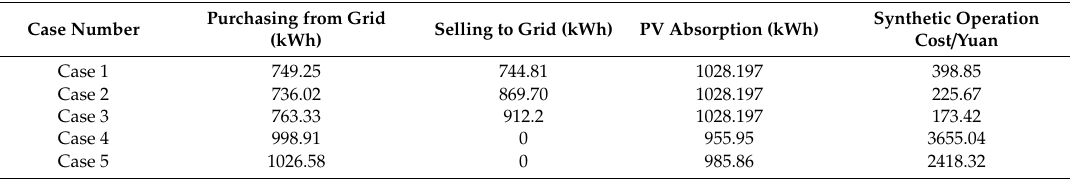
Table 15. The electricity purchasing and selling status, PV absorption status and synthetic operation cost in five